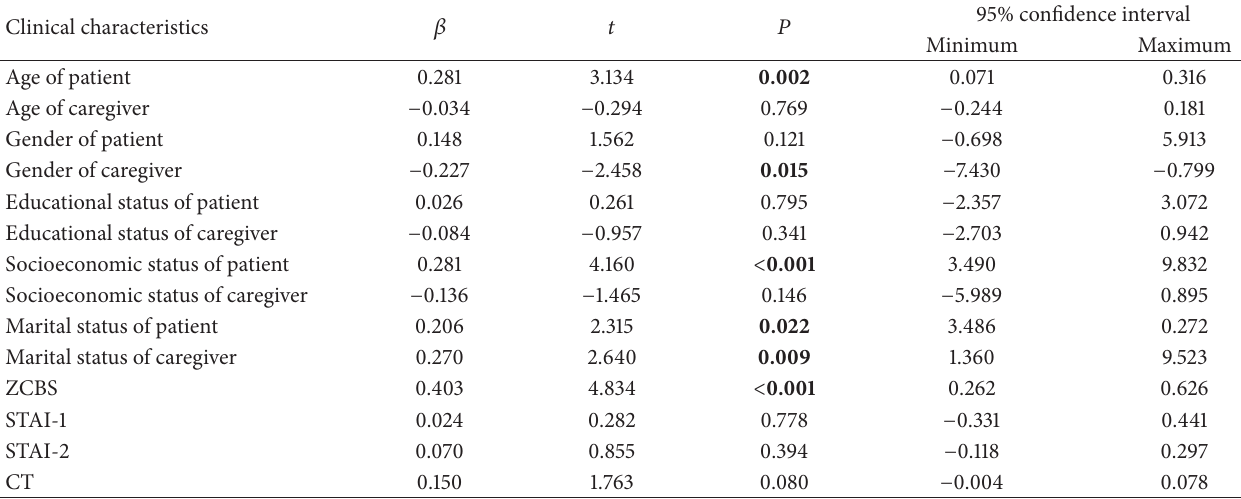
Table 4: Linear regression analysis for depressive symptoms of